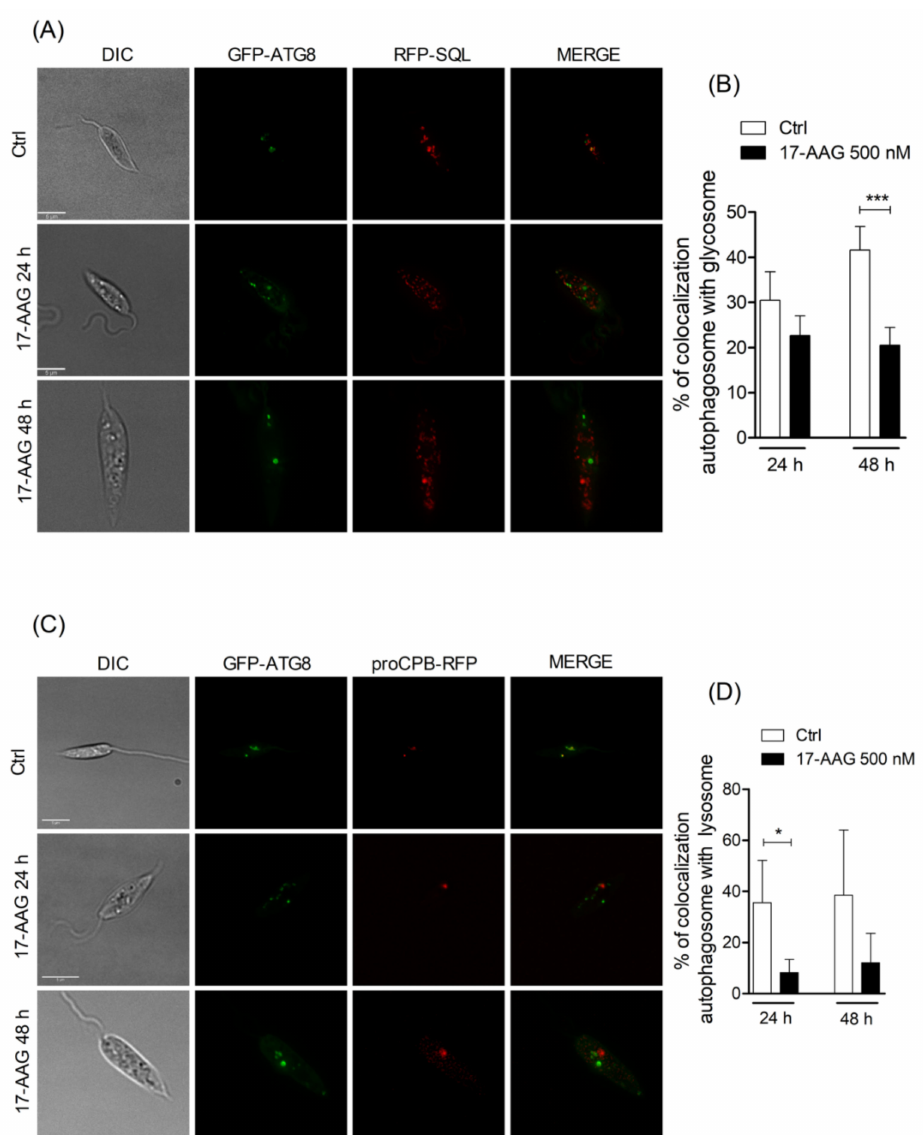
Figure 2. Analysis of fusion between autophagosomes and glycosomes or lysosomes. ( A ) Axenic promastigotes of Leishmania expressing GFP-ATG8 and RFP-SQL were treated or not with 17-AAG (500 nM) and imaged by fluorescence microscopy. ( B ) Quantification of autophagosome-glycosome colocalization after treatment of Leishmania with 17-AAG. ( C ) Axenic promastigotes of Leishmania expressing ATG8-GFP and proCPB-RFP were treated or not with 17-AAG (500 nM) and imaged by fluorescence microscopy. ( D ) Quantification of Leishmania autophagosome-lysosome colocalization after treatment with 17-AAG. Bars represent medians ± SD from one out of three independent experiments (Unpaired t test, *** p = 0.0006, * p =